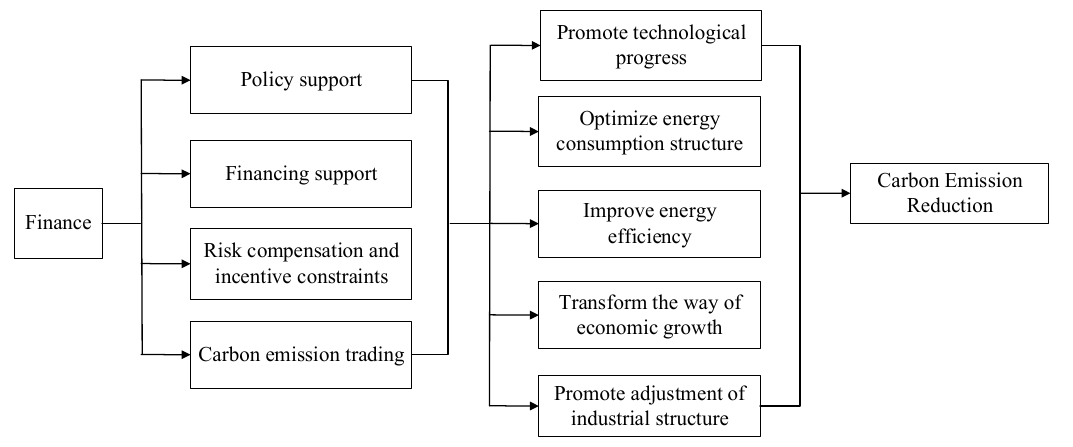
Figure 1. Path analysis of financial development affecting the reduction in carbon emissions.